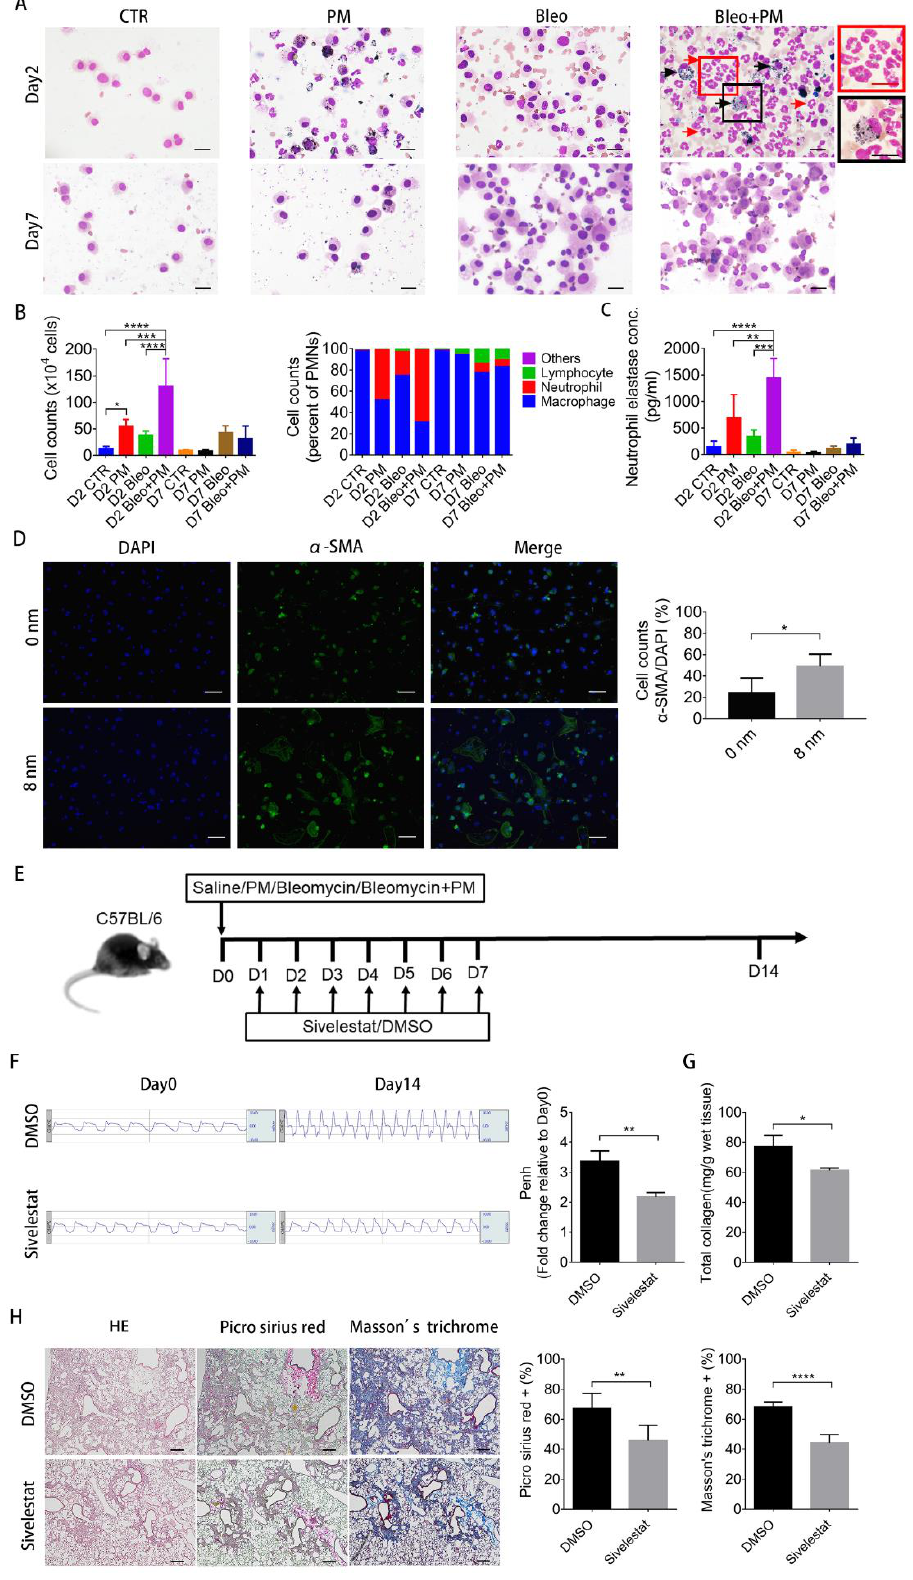
Figure 2. Neutrophil elastase is involved in PM-enhanced lung function deterioration and pulmonary fibrosis. ( A – D ) C57BL / 6 mice were intratracheally instilled with saline (Control), 200 µ g particulate matter (PM), 2 U / kg bleomycin (Bleo) or 200 µ g PM plus 2U / kg bleomycin (Bleo + PM) at day 0. The mice were sacrificed and the 2-bronchoalveolar lavage fluid (BALF) were harvested at 2 and 7 days for ( A ) Liu’s staining (40 × ) and ( B ) quantification of the changes in the immune cell profiles. Red